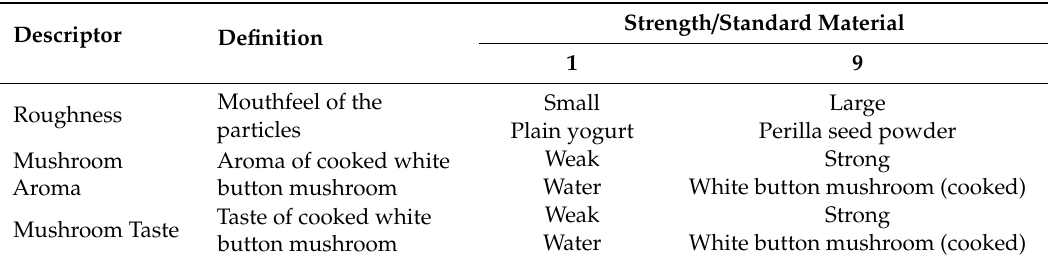
Table 2. Descriptors used for the sensory evaluation of vitamin D 2 fortified mushroom powder by descriptive